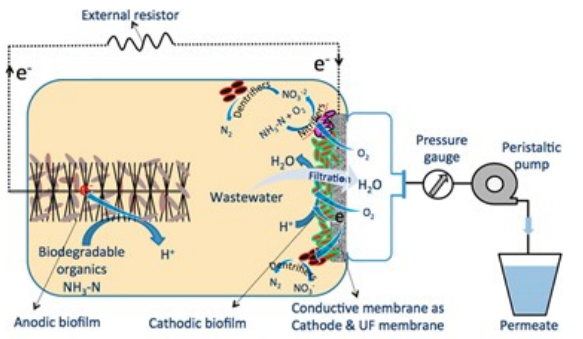
Figure 12. Schematic of bioelectrochemical system equipped with a multi-walled carbon nano- tube-based ultrafiltration membrane as cathode electrode for filtering wastewater and oxygen reduction reaction. Reproduced with permission from [27] .